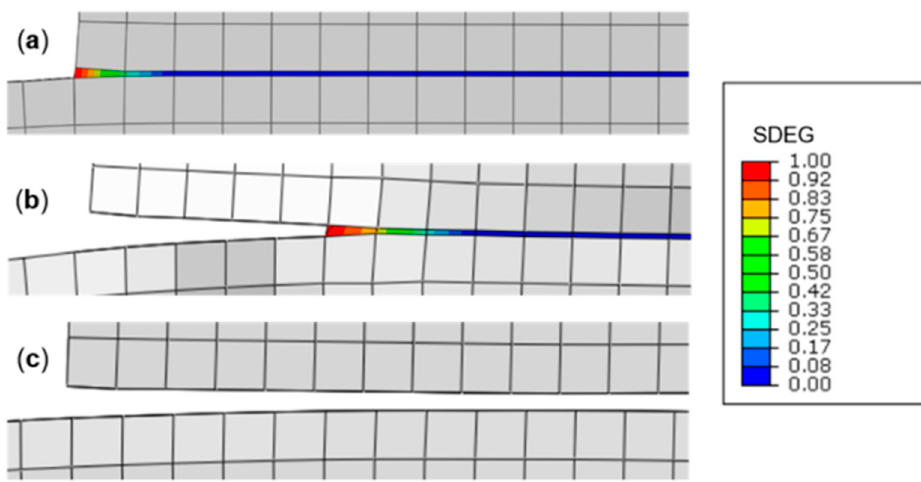
Figure 29. Progressive failure process of the adhesive layer in the lap-shear joint, ( a ) damage initiation at the overlap edges (SDEG-% = 0), ( b ) propagation towards the joint centre (SDEG-% ≈ 40), ( c ) joint failure (SDEG-% = 100). Reproduced with Creative Common License [239].